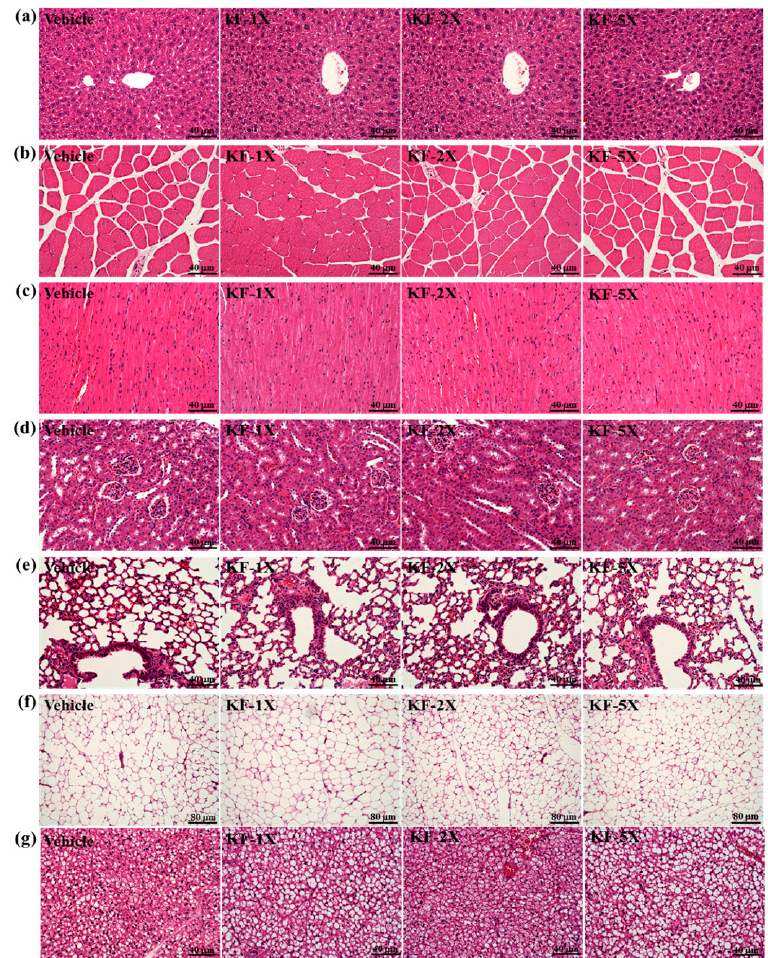
Figure 6. Effects of kefir (KF) supplementation on ( a ) liver; ( b ) muscle; ( c ) heart; ( d ) kidney; ( e ) lungs; ( f ) epididymal fat pad (EFP); and ( g ) brown adipose tissue (BAT). Specimens were observed using a light microscopy. Hematoxylin and eosin stain, magnification: ×200 ( a – e ) and ×100 ( f , g ). Vehicle (glucose water), KF-1X (2.15 g/kg/day KF), KF-2X (4.31 g/kg/day KF), and KF-5X (10.76 g/kg/day KF).